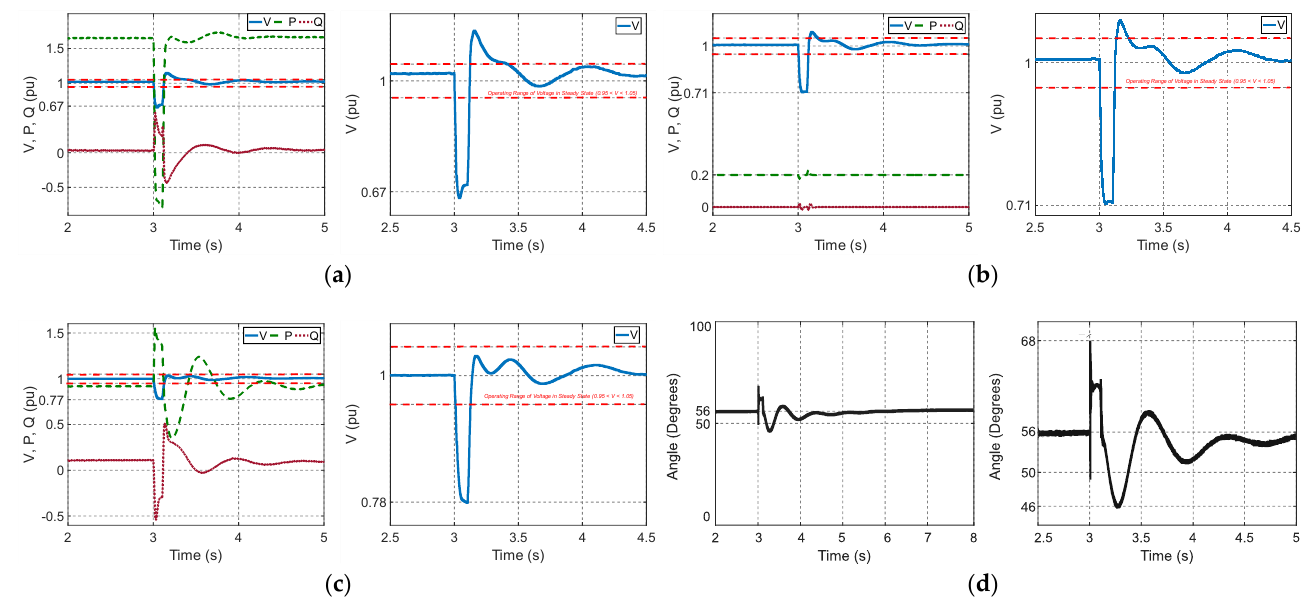
Figure 10. Scenario 1 results for the system generators: voltage (V), active power (P), reactive power (Q), and voltage zoom. ( a ) Wind power plant; ( b ) solar power plant; ( c ) hydroelectric power plant; ( d ) hydroelectric power plant: loading angle and zoom.